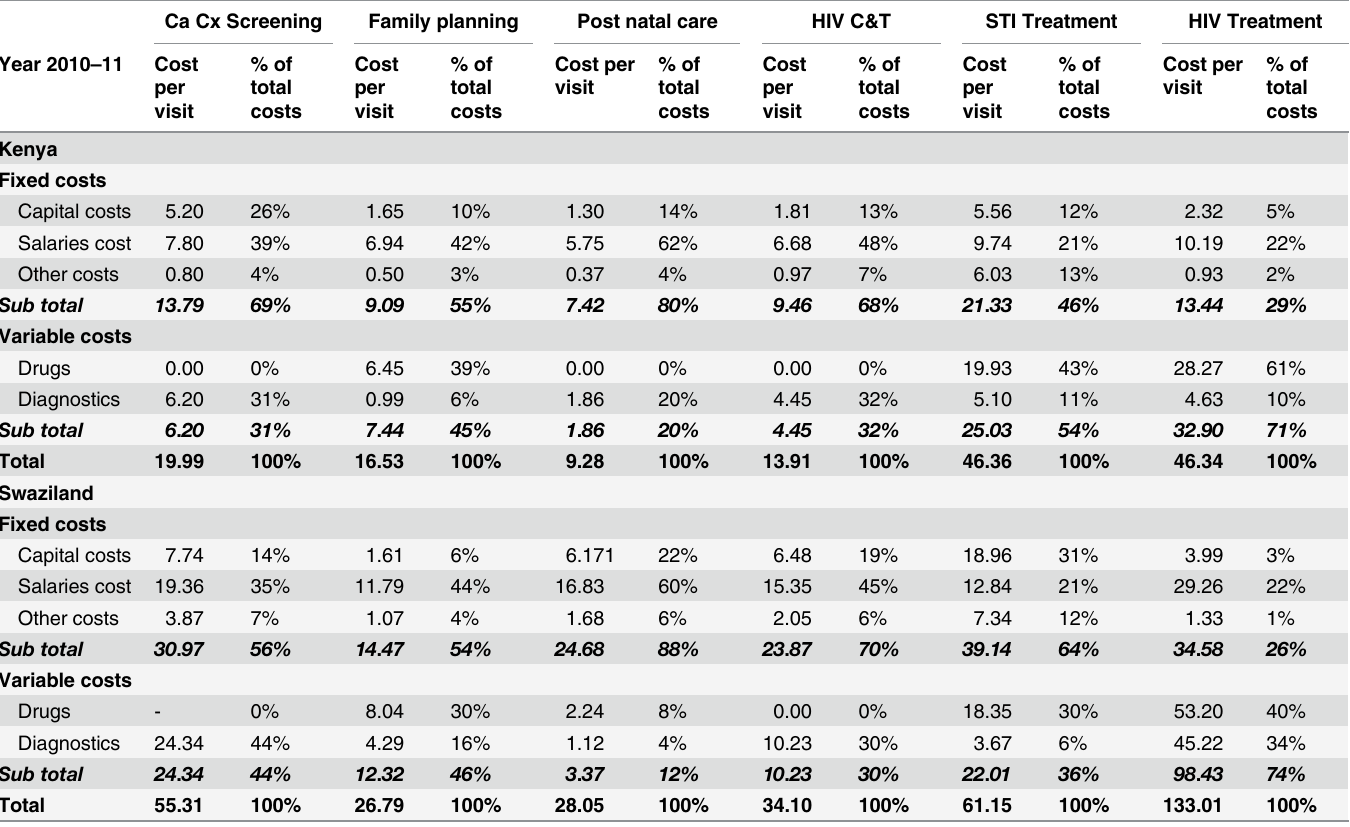
Table 4. Distribution of unit cost (Int$ 2013) by input